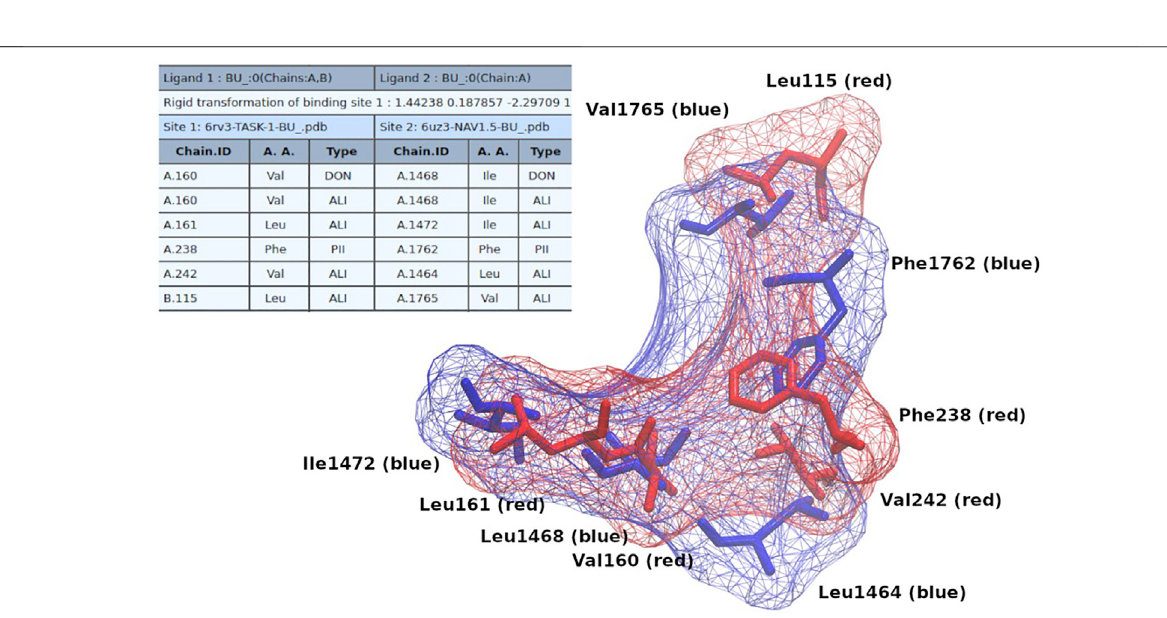
Frontiers in Pharmacology |